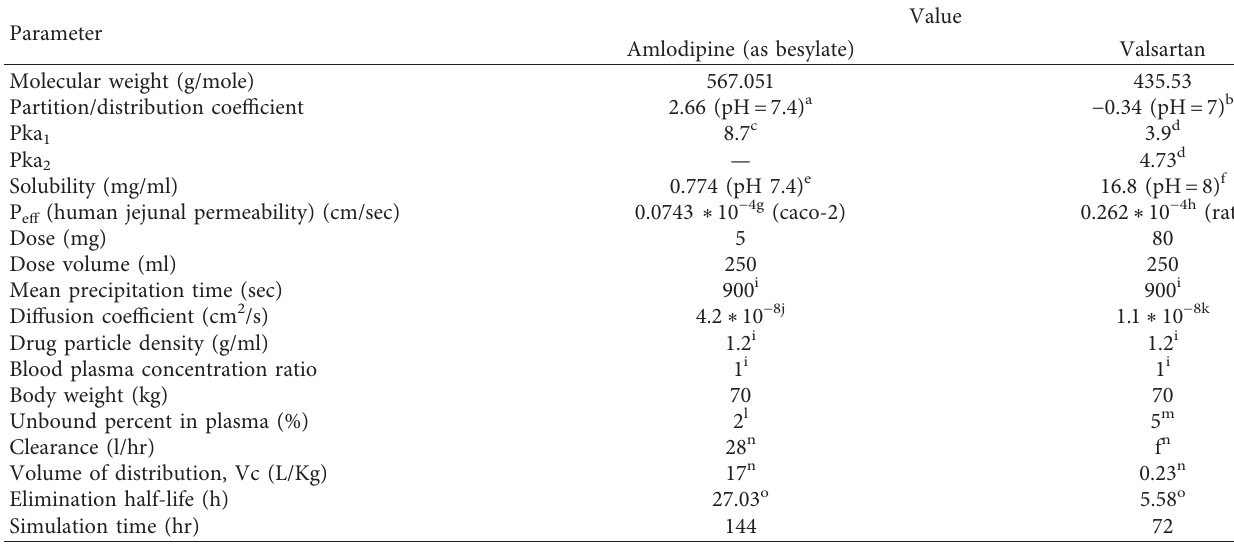
Table 2: Simulation input